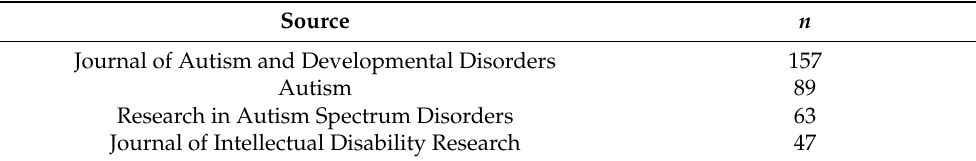
Table 7. Source of origin.